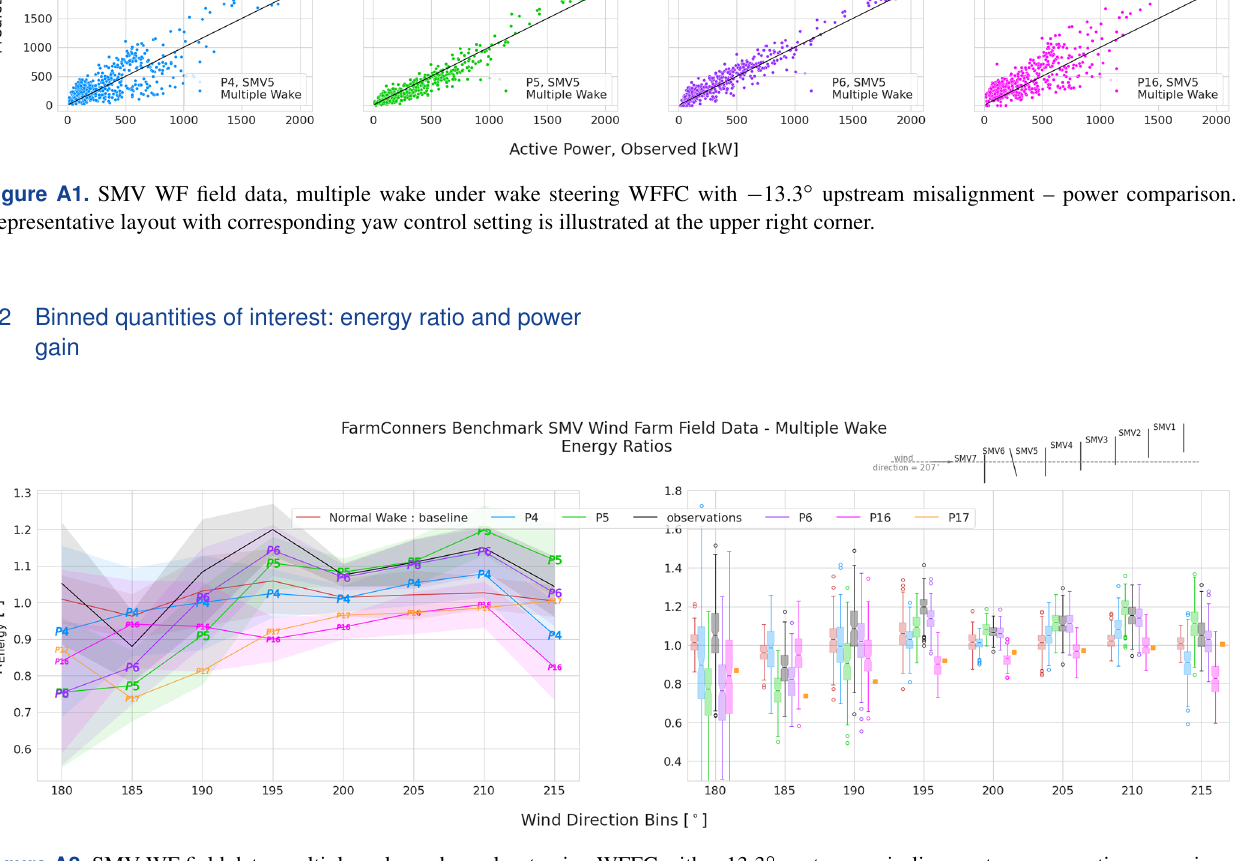
Figure A2. SMV WF field data, multiple wake under wake steering WFFC with − 13 . 3 ◦ upstream misalignment – energy ratio comparison. Representative layout with corresponding yaw control setting is illustrated at the upper right